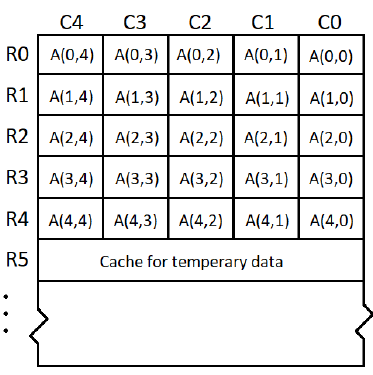
Figure 5. Data mapping of the 1600-bit state array.